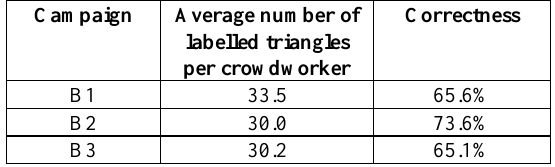
Table 6 . Results of labelling without gamification in study B.